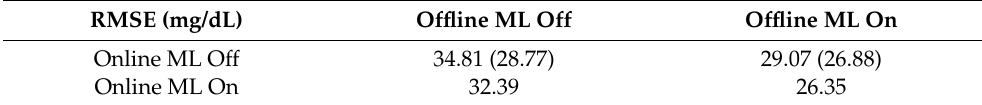
Table 3. The summary of results for the BGL prediction task with the non-stationary target profile varying between adult#002 and adult#003. Numbers in the brackets are from the model without the sliding window, and the others are with the sliding window (length = 576). ML denotes meta-learning. RMSE (mg/dL) Offline ML Off